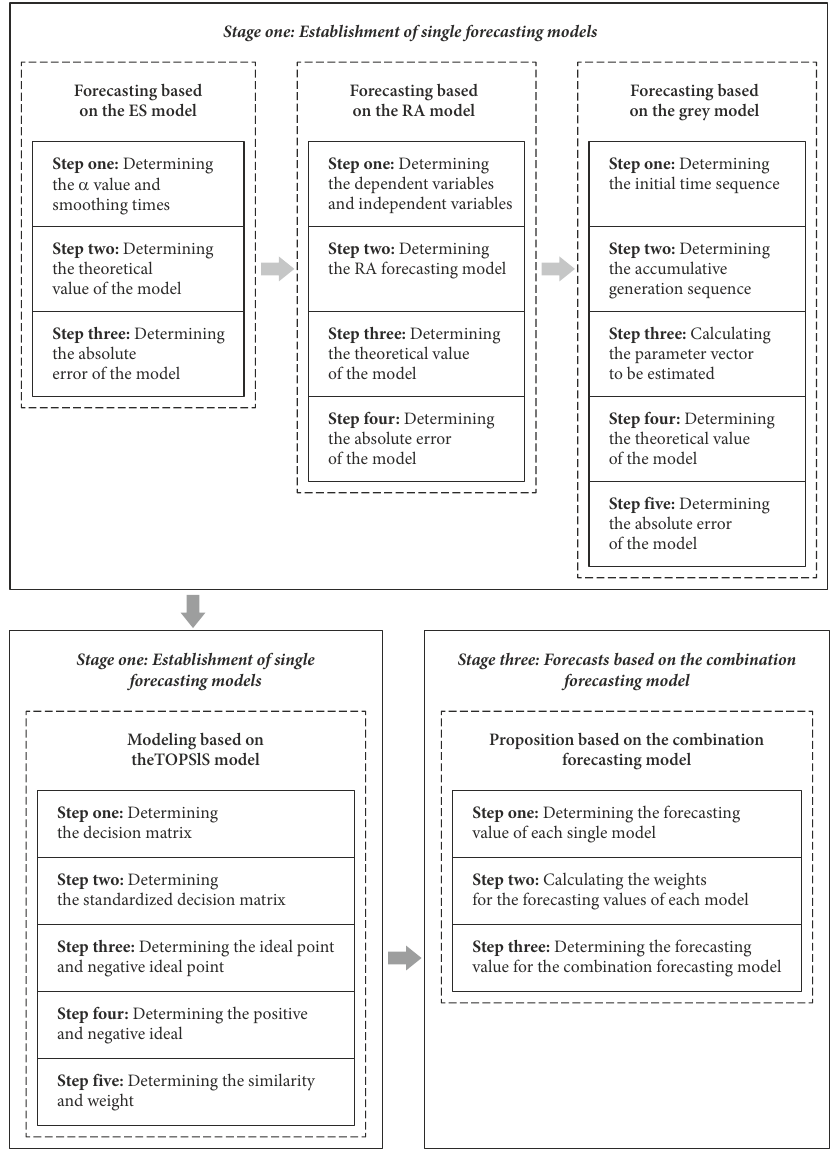
Figure 2. Analysis